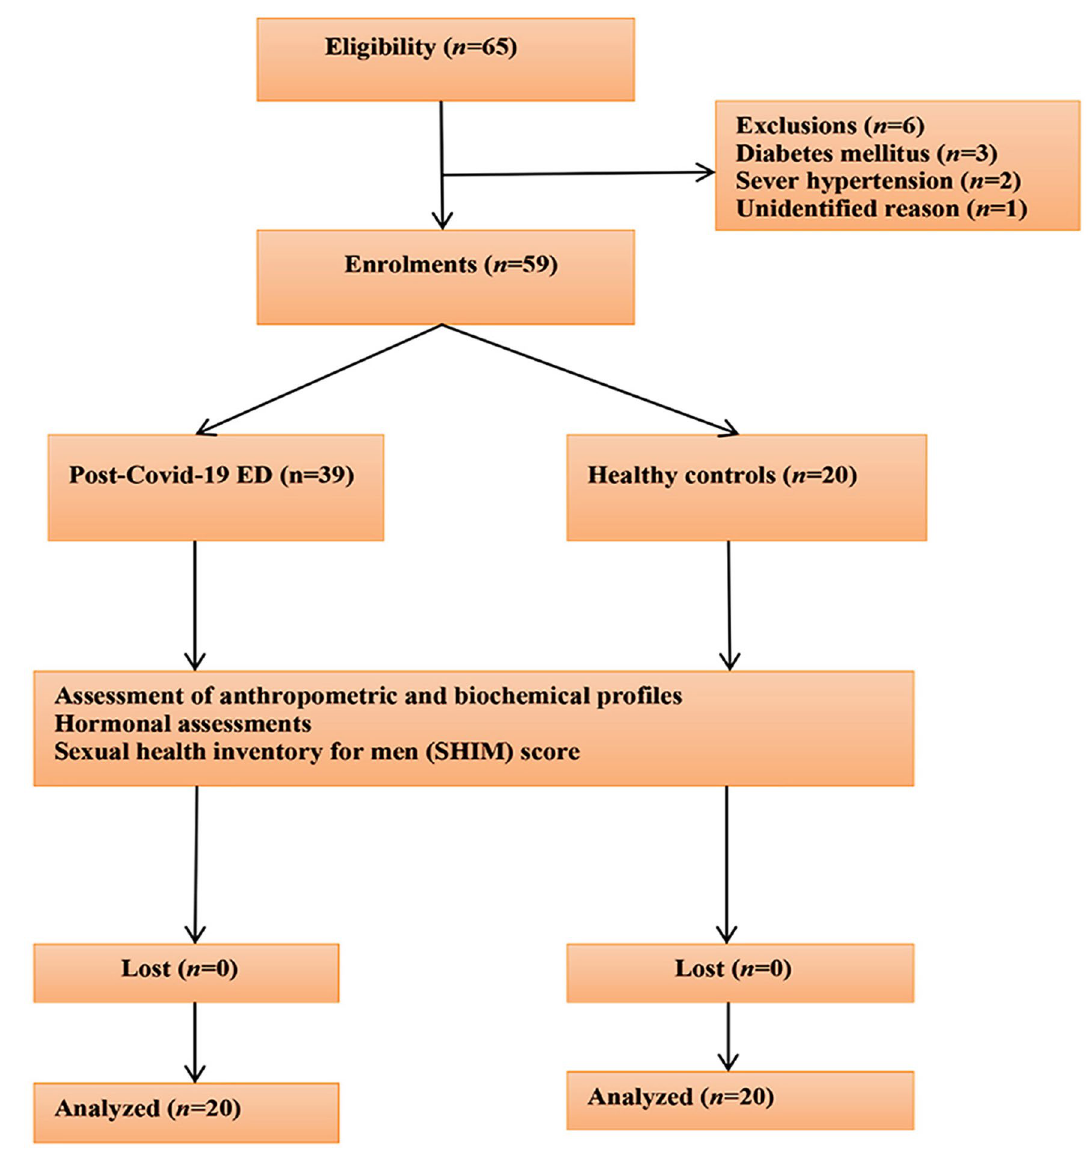
Figure 2. Consort-flow diagram for patients in the present